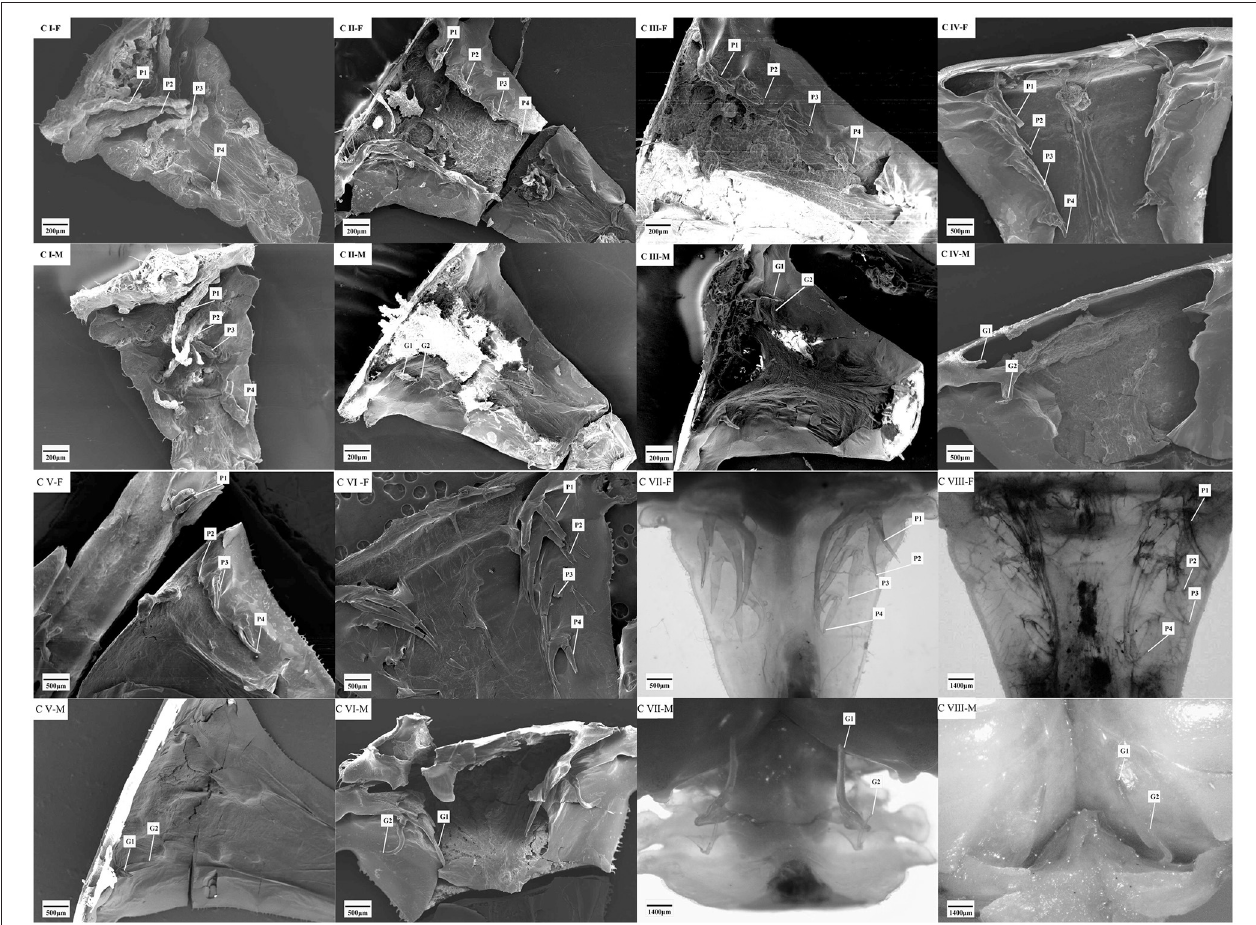
FIGURE 5 | The secondary sexual characteristics of the S. paramamosain crablets. C I, C II, C III, C IV, C V, C VI, C VII, and C VIII represent crablets of stages I, II, III, IV, V, VI, VII, and VIII. F, female; M, male; G1 and G2 represent gonopods 1 and 2; P1, P2, P3, and P4 represent pleopods 1, 2, 3, and